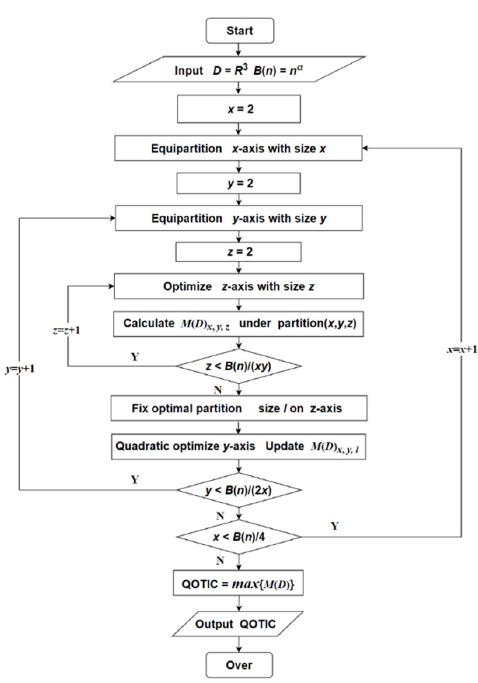
Figure 5. The flow chart of QOTIC